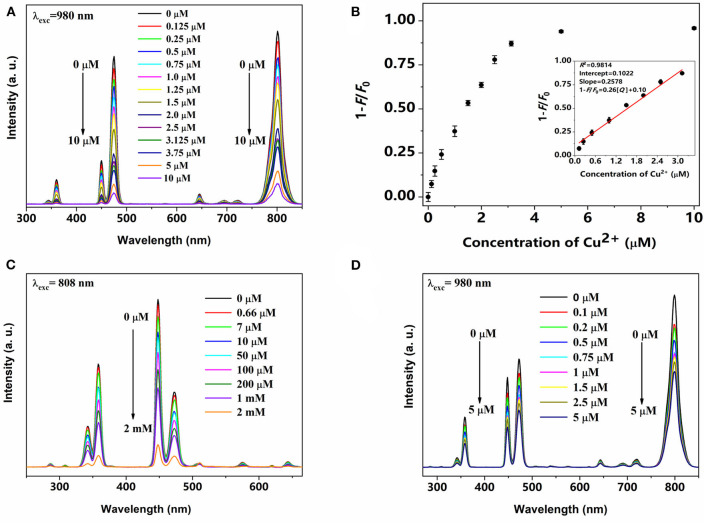
Upconversion emission spectra of PAA-NaYb0.5Nd0.5F4@NaYb0.5Gd0.49Tm0.01F4@NaGdF4 UCNPs with various concentration of Cu2+ under (A) 980 nm and (C) 808 nm laser excitation, respectively; (B) The plot of emission quenching efficiency (1-F/F0) vs. the Cu2+ concentration in (A); (D) Upconversion emission spectra of PAA-NaYbF4@NaYb0.5Gd0.49Tm0.01F4@NaGdF4 UCNPs with various concentration of Cu2+ under 980 nm laser excitation.